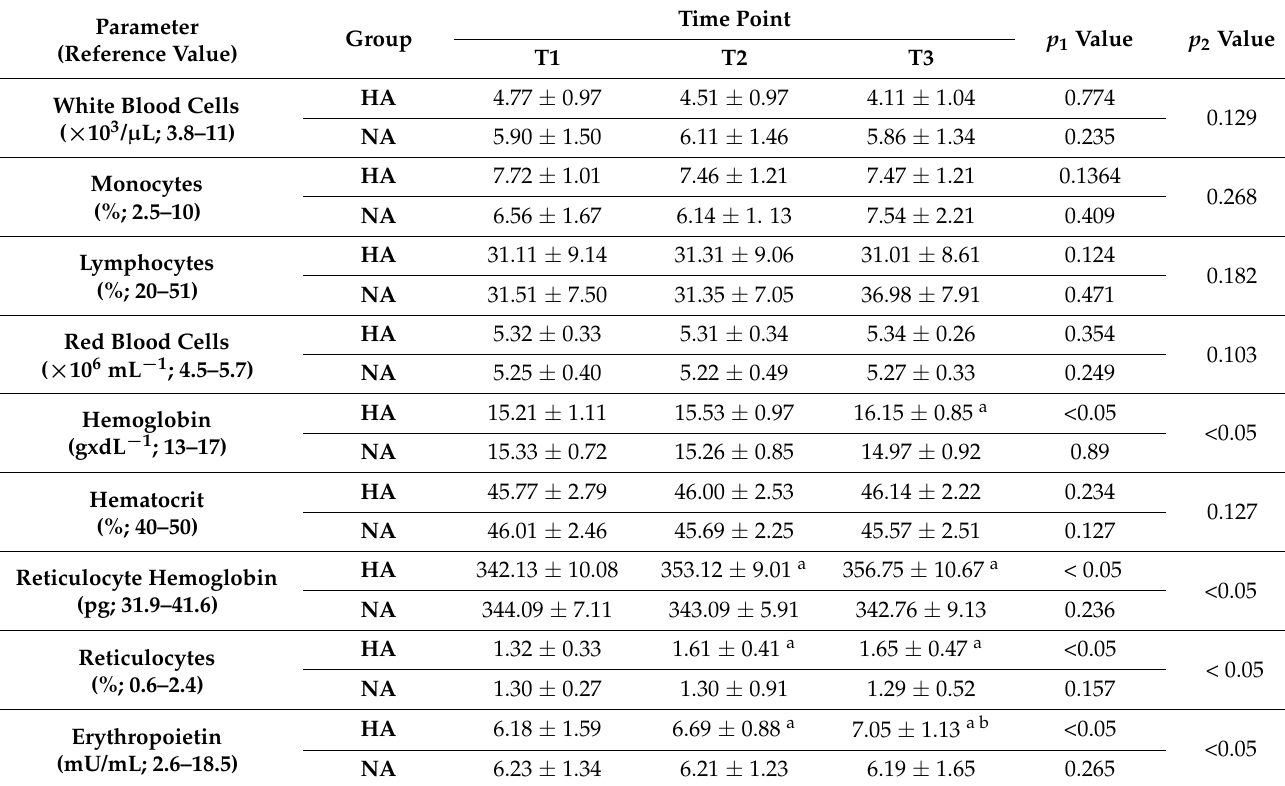
Table 6. The blood biomarkers of the athletes in the two study groups at the three time points of the